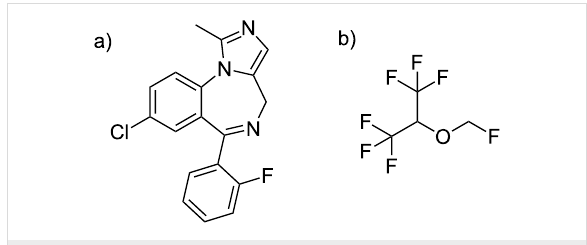
of the Caco-2 cell line, not any cytotoxic effect could be detected for all of the tested concentrations of 5a after 2 h of incubation, while DIMEB was already highly toxic at 25 mg/mL. After 24 h of incubation, 5a also showed a rather weak toxicity, while DIMEB was already highly toxic at the clinically relevant concentration (see Figure 3). The effect of the culture medium was